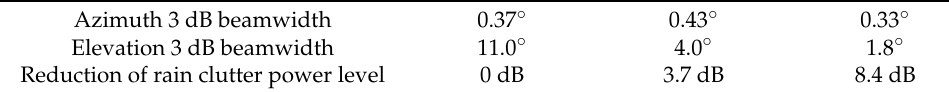
Table 3. Narrower radar beams reduce rain clutter